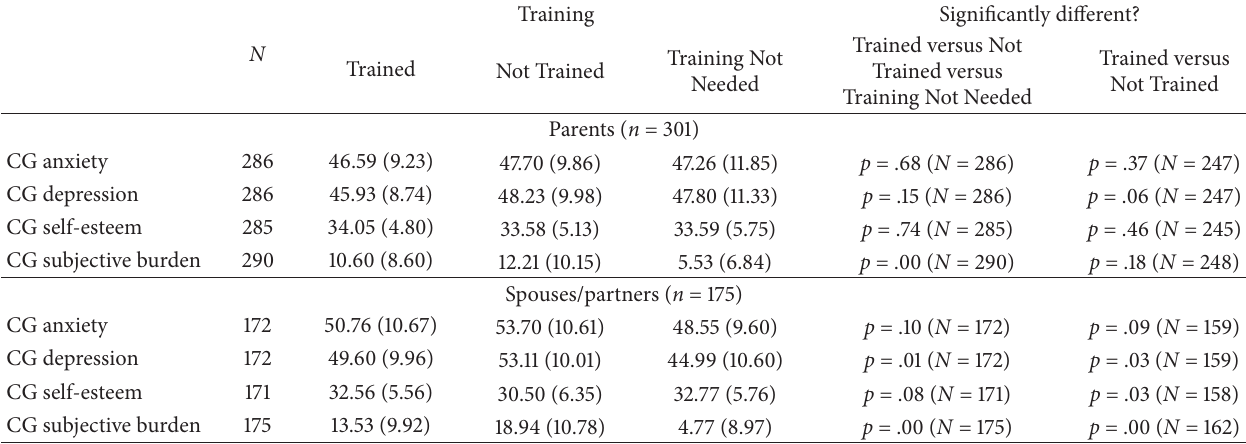
Table 6: Differences in caregiver mental health based on training received for supporting emotions based on relationship to care recipient. Training N